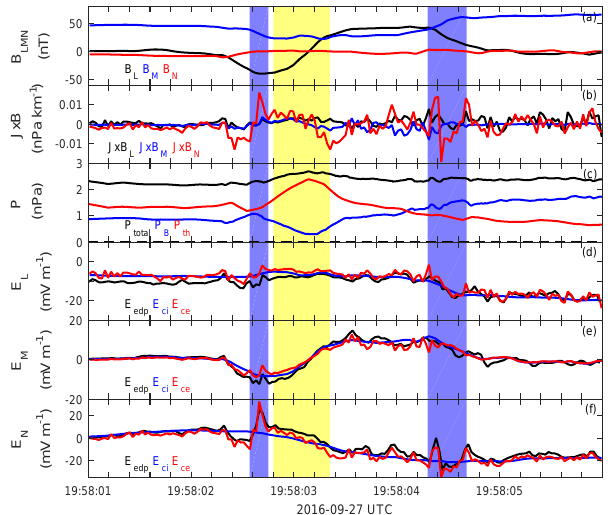
Figure 6. The measured electric field and plasma convective elec- tric field. (a) The magnetic field; (b) J × B force; (c) the plasma thermal, magnetic and total pressures; (d, f) the measured electric field (black), the ion convective electric field (blue) and the electron convective electric field (red) in the L , M and N direction, respec- tively. The color shaded region is the same as in Fig. 5. currents perpendicular to the magnetic field (Gershman et al., 2016; Goodrich et al.,